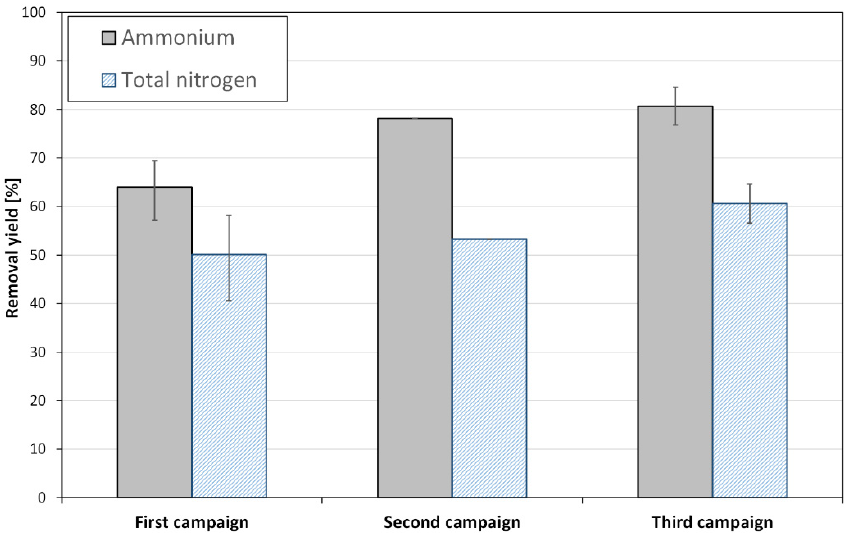
Figure 5. Removal yield for N tot e N-NH 4+ , considering evaporation. Baffles show the variation among tests of the same campaign.